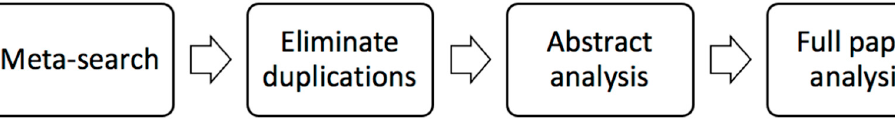
Figure 3. Screening process .